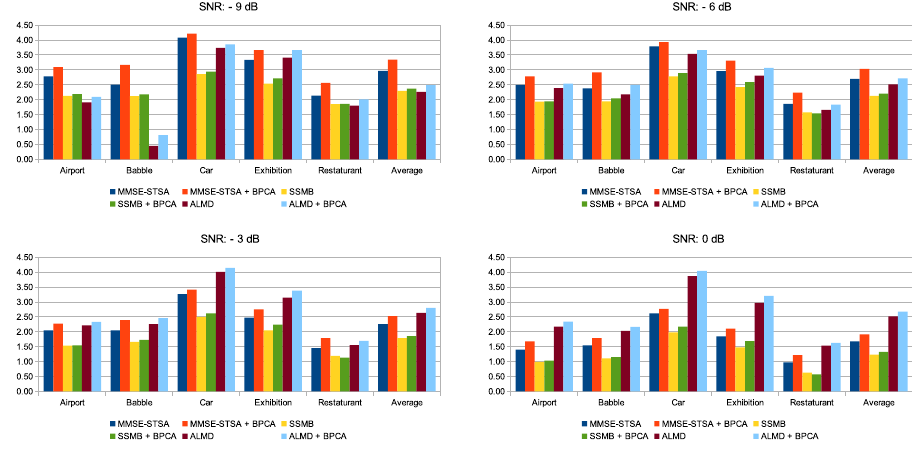
Figure 9. PESQ scores for all noise types and all SNR noise levels. (For interpretation of the bar colors, the reader is referred to the web version of this